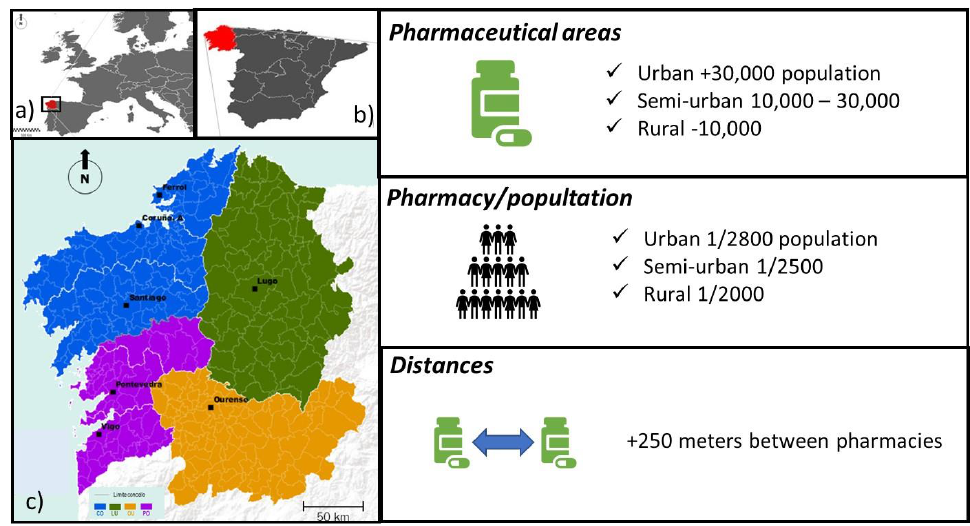
Figure 3. Geographical location and general characteristics that pharmacies in Galicia (Spain) must comply with. Geographic location of Galicia ( a ), in Europe ( b ), in Spain ( c ). Galicia is administratively divided into four provinces and 313 municipalities (by law, each municipality can have a pharmacy).